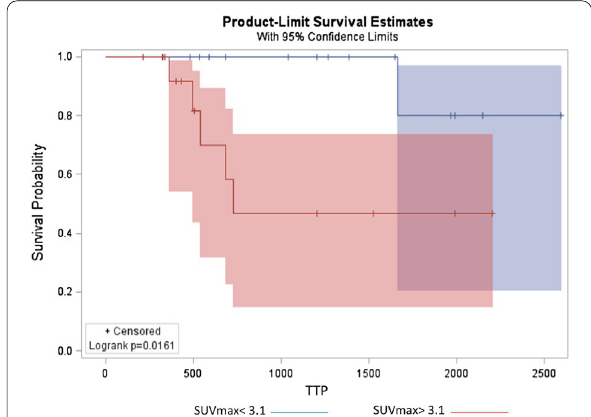
Fig. 6 Early interim PET2‑SUVmax. Kaplan–Meier plot analysis of PET2‑SUVmax with TTP ( p 0.016). Patients were stratified by the = median SUVmax 3.1 =